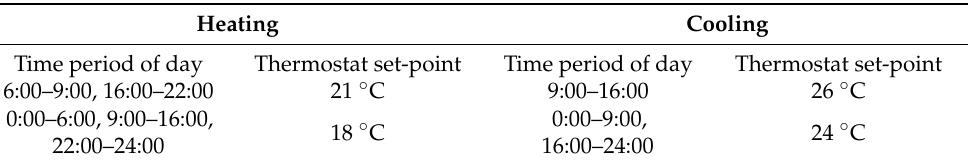
Table 2. Room thermostat set-points.